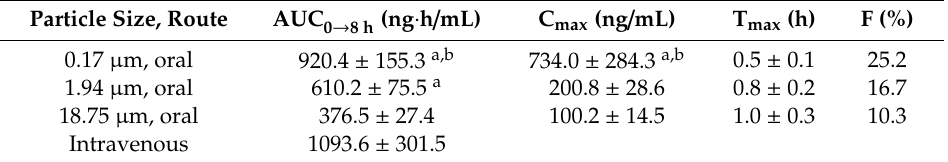
Table 4. Pharmacokineticdataof trans -resveratrolafteroraladministrationandintravenousadministration.